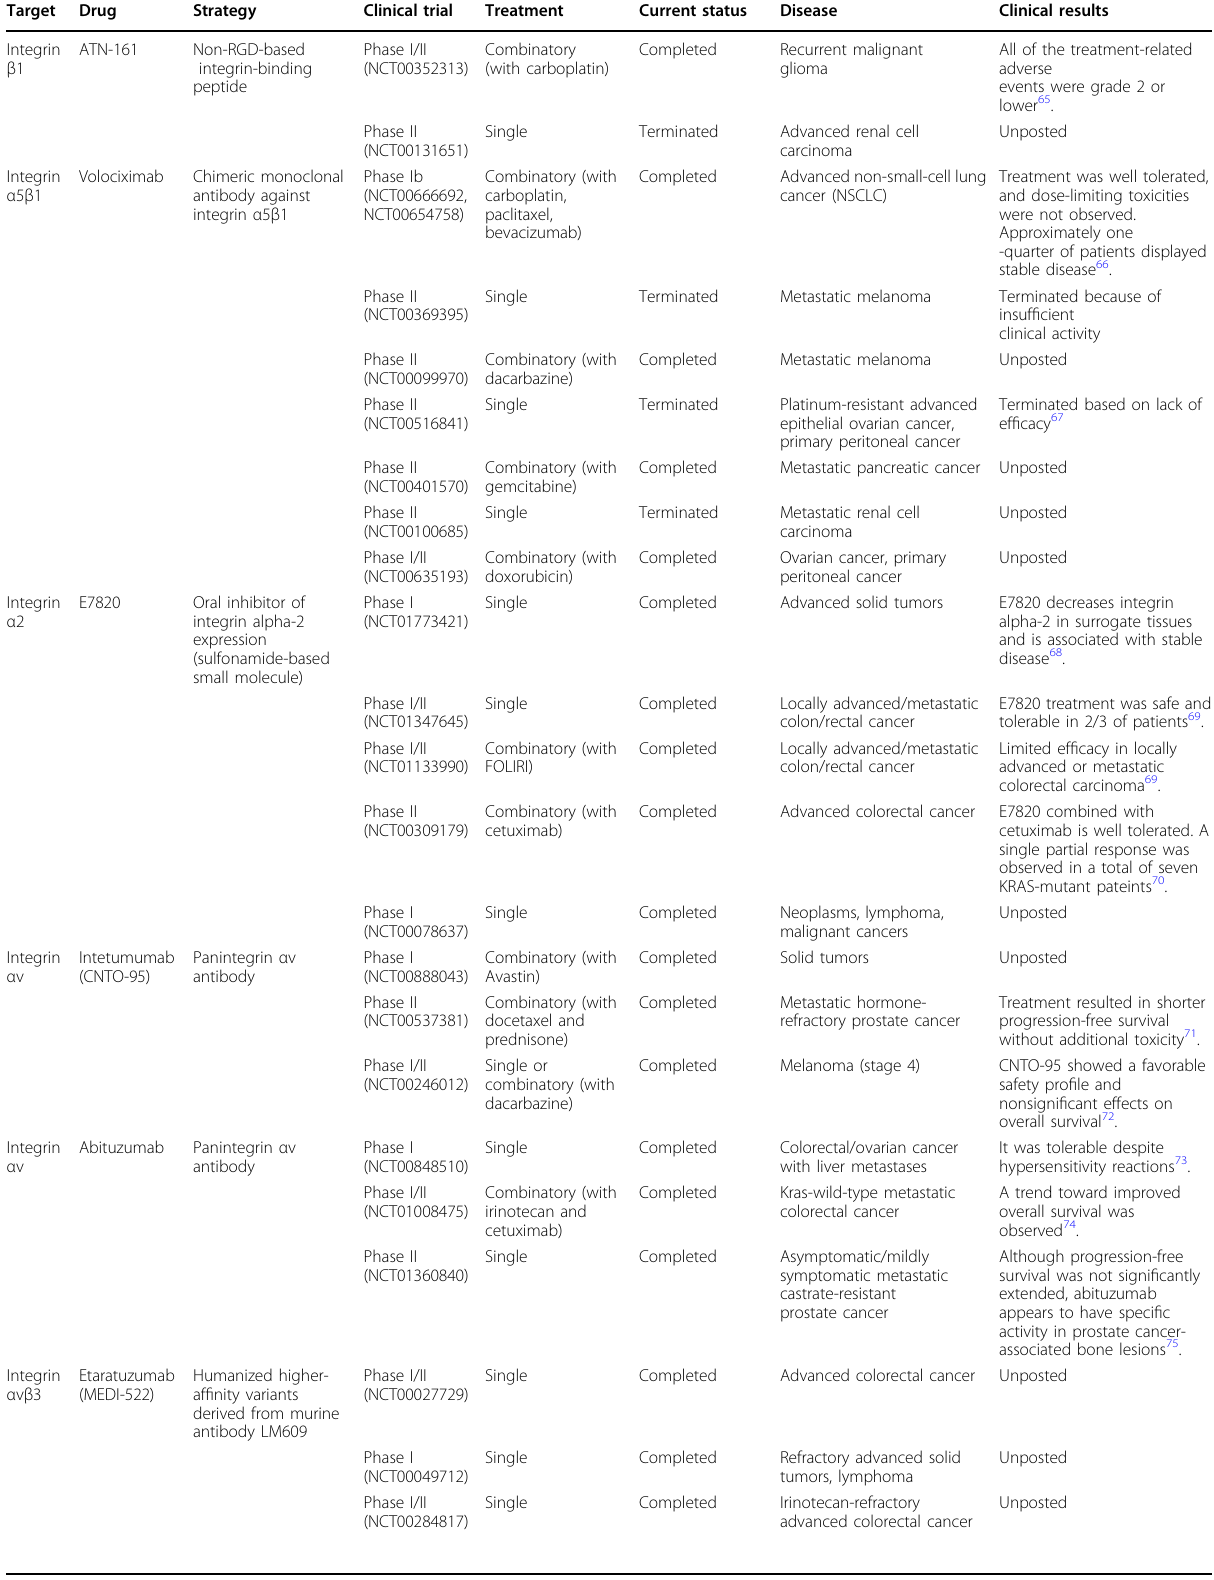
Table 1 Potential molecular targets and therapeutic agents linked to the DCC reawakening